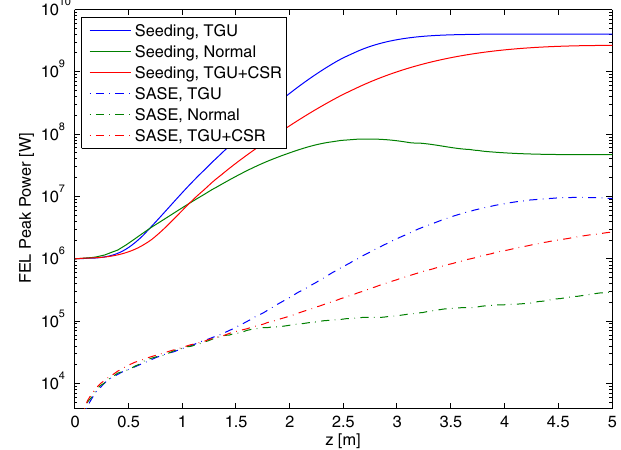
FIG. 7. SASE (dash dotted) and seeded (solid) FEL peak power growth based on TGU cases without CSR (blue), with CSR (red) and on normal undulator case (green) along the undulator.